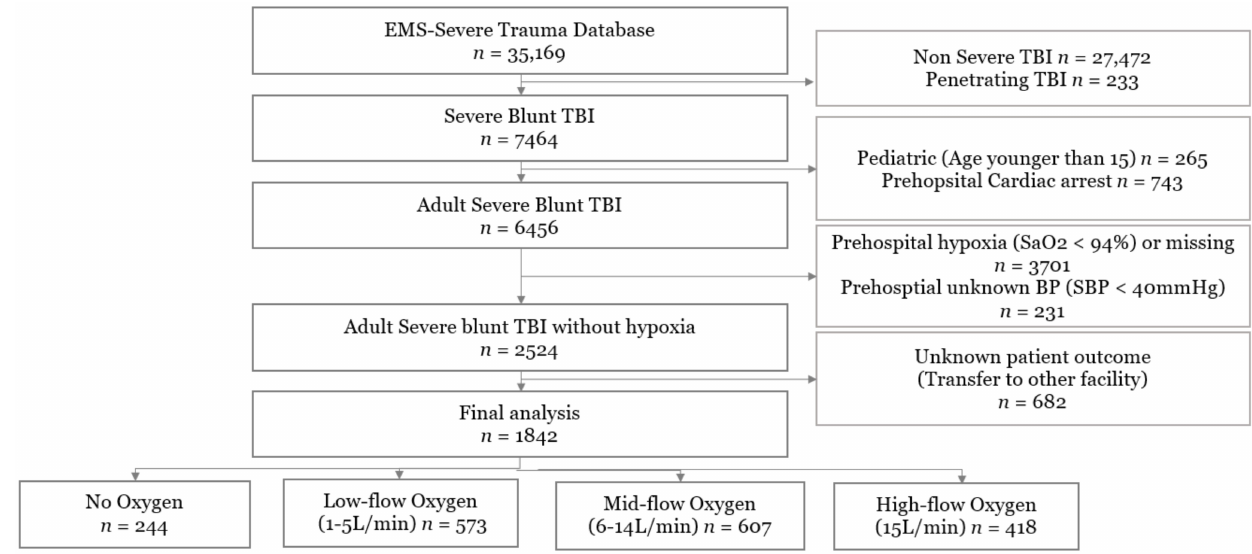
Figure 1. Inclusion of study population. Table 1. Demographics of the study